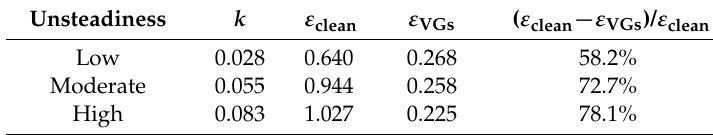
Table 3. Hysteresis intensity of the lift coefficient with and without the baseline